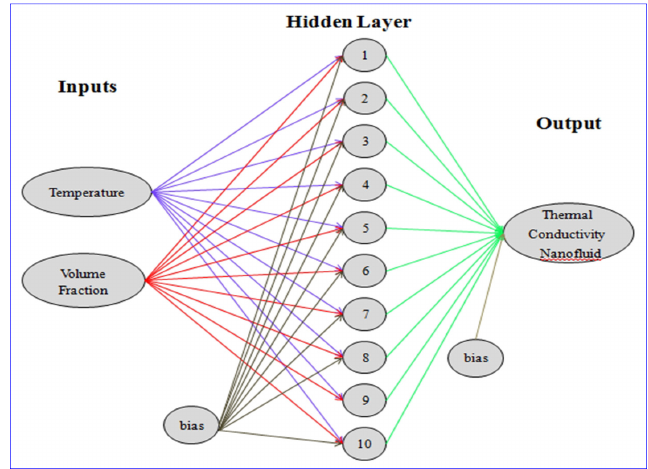
Fig. 3: Illustration of inputs, outputs, and hidden layers by neural Fig.3:Illustration of inputs, outputs, and hidden layers by neural network